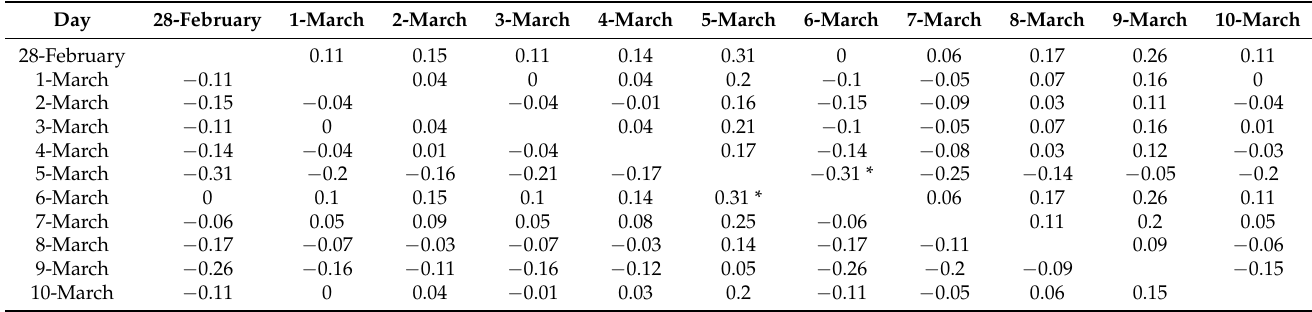
Table 7. Post hoc test for all pairwise comparisons of LMF-HRV-correlation mean between days for the Saudi Arabia’s group (* p <